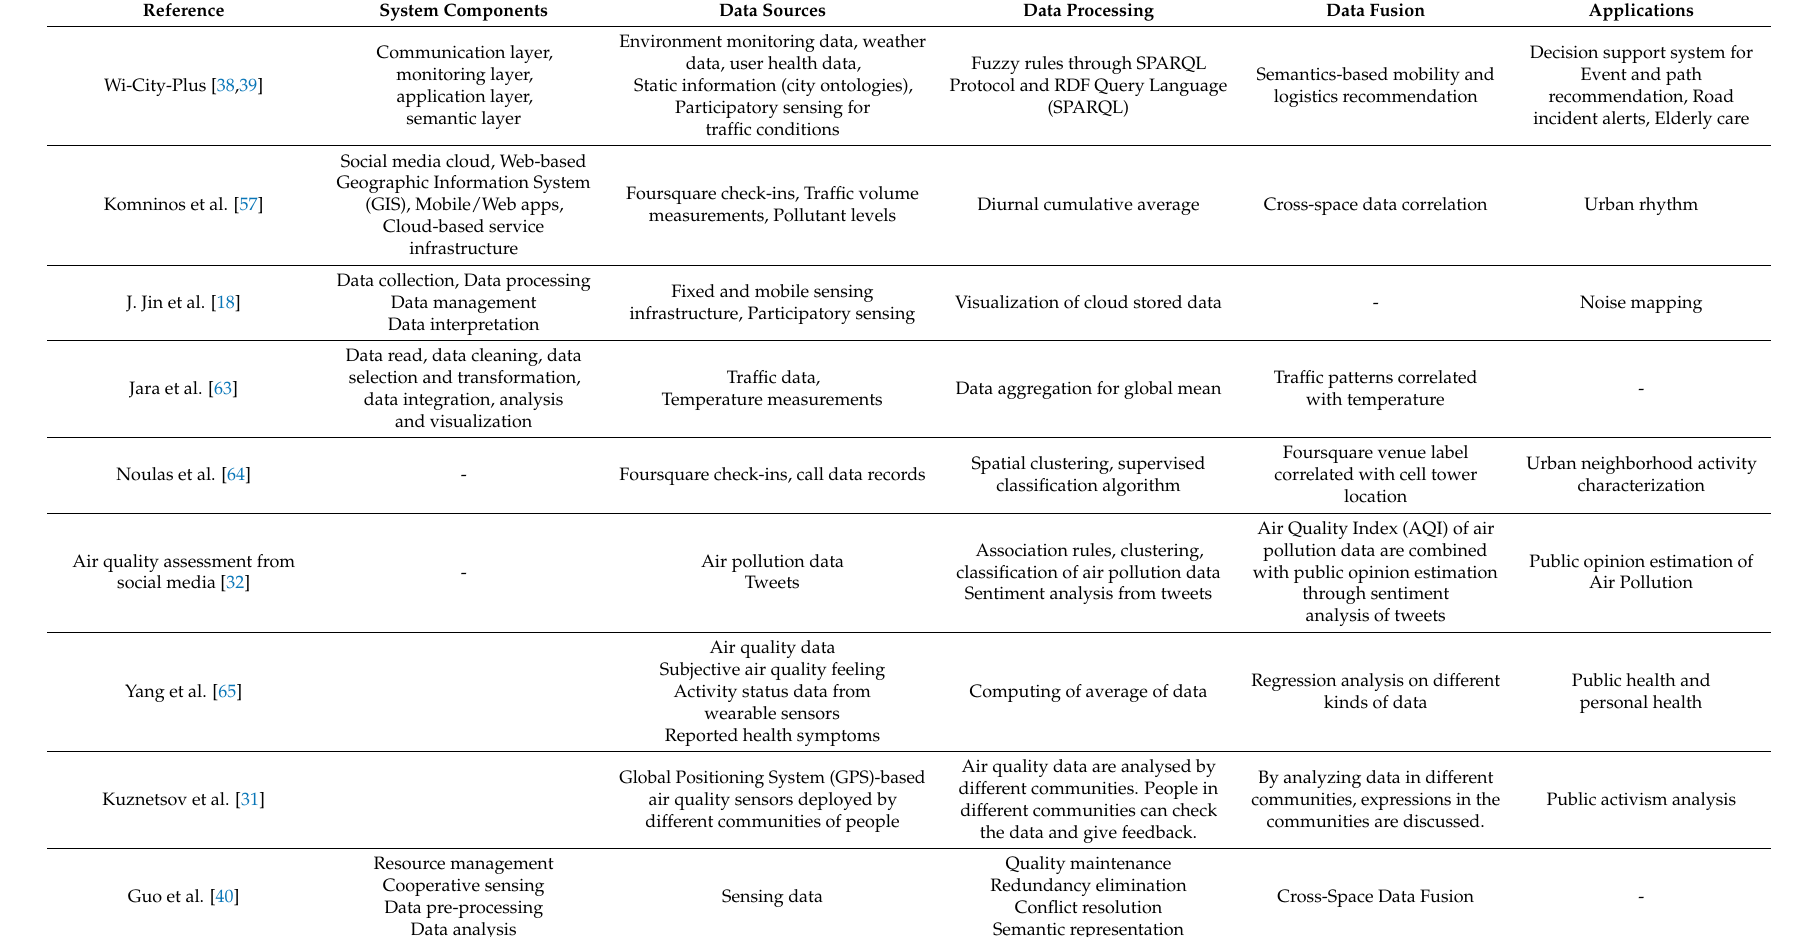
Table 1. A Taxonomy of Urban CPSS